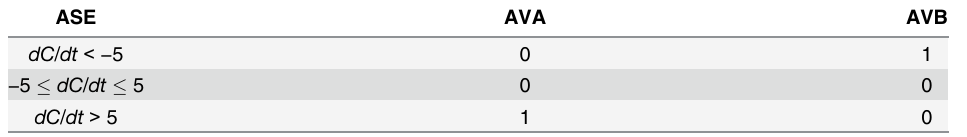
Table 1. Rules for the simulation of chemotaxis in C. elegans based on Dunn et al. [19]. ASE AVA